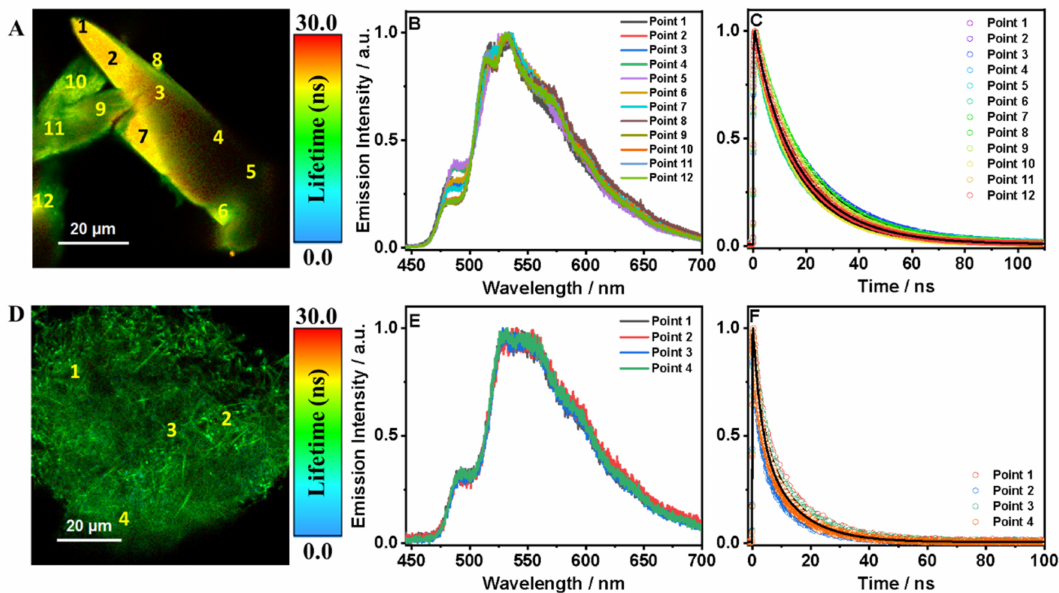
Figure 6. ( A ) FLIM image, ( B ) emission spectra, ( C ) emission decays at different points, ( D ) FLIM images, ( E ) emission spectra and ( F ) emission decays at different points of T12F-1(124TCB) crystal. The solid lines are from the best fit using a multiexponential function. The inset in ( C , F ) are the histogram of the emission anisotropy and the anisotropic images of T12F-1(124TCB) in the solid state. The excitation wavelength was 390 nm. Table 5. Values of time constants ( τ i ) and normalized (to 100) pre-exponential factors (a i ) obtained from the best fit of the emission decays collected at selected points of T12F-1(124TCB), as indicated in Figure 6. The errors in the time constant values are about